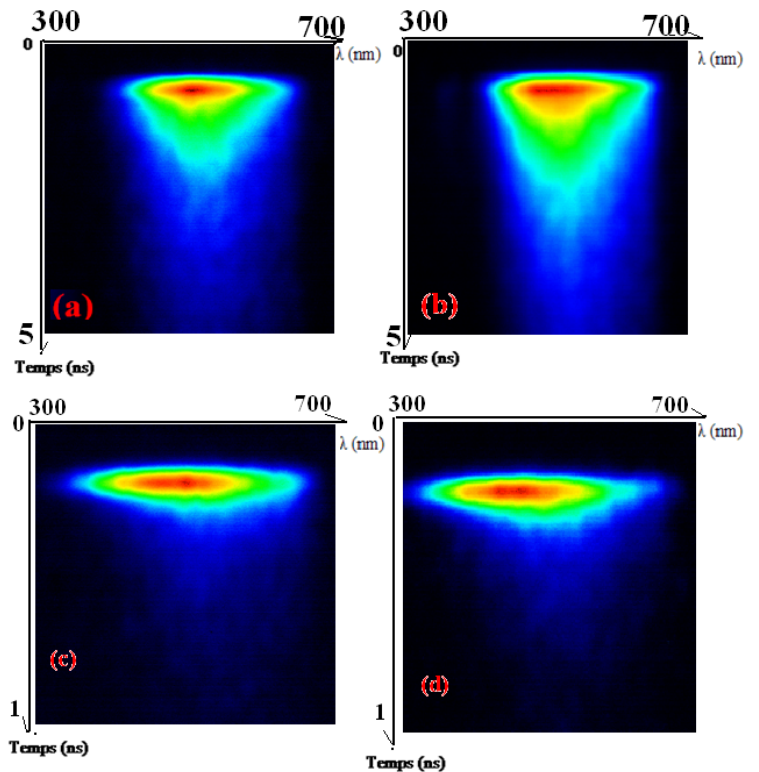
Figure 10. 3D-maps TR-PL of OBMPA (a) solution, (b) solution, (c) thin film and of OMPA, (d) thin